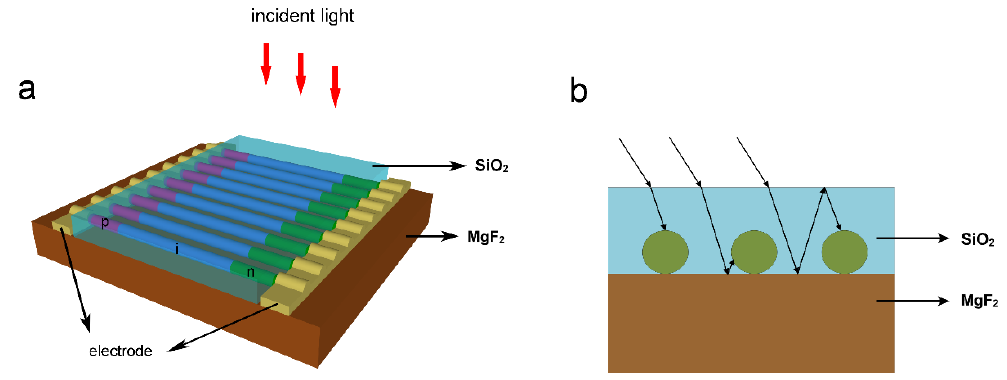
Figure 5. ( a , b ) Schematic diagram and working principle of the absorption-enhanced (AE-HNA)